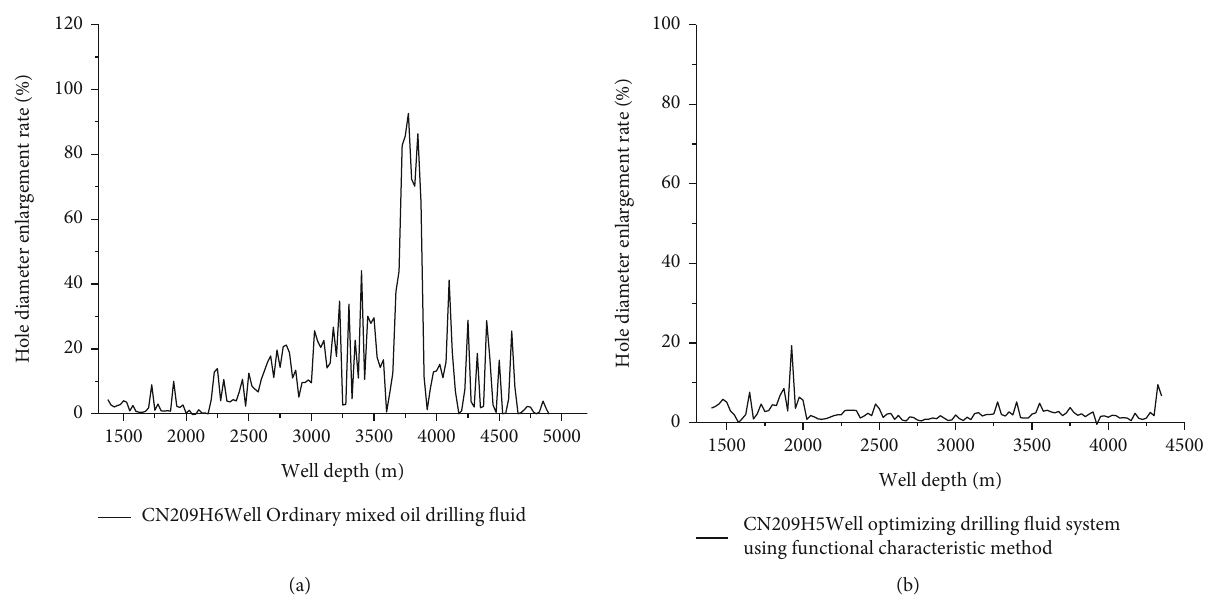
Figure 10: Comparison of the caliper expansion rate of fi eld application